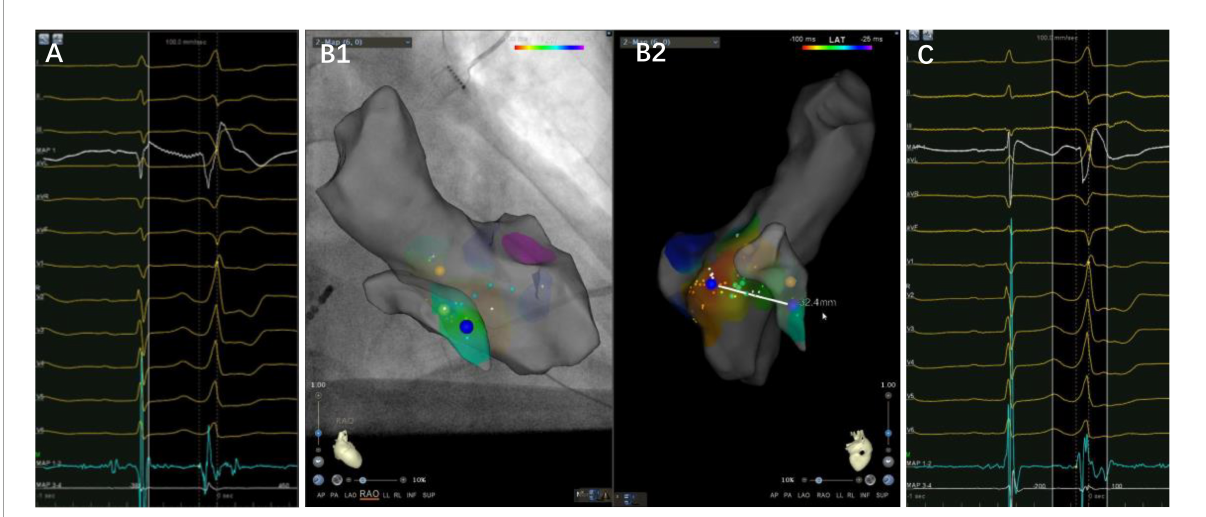
FIGURE4 A case of premature ventricular complex ablated from the left side of the basal septum. Panels (A–C) are the left side target potential, three-dimensional map and the earliest activation at the under-valve area of right side, respectively. The target electrogram precedes the QRS onset by 36 ms, while the earliest activation on the right side only 14 ms, with a distance of 32.4 mm between them. Notice a small “a” potential at the target electrogram.